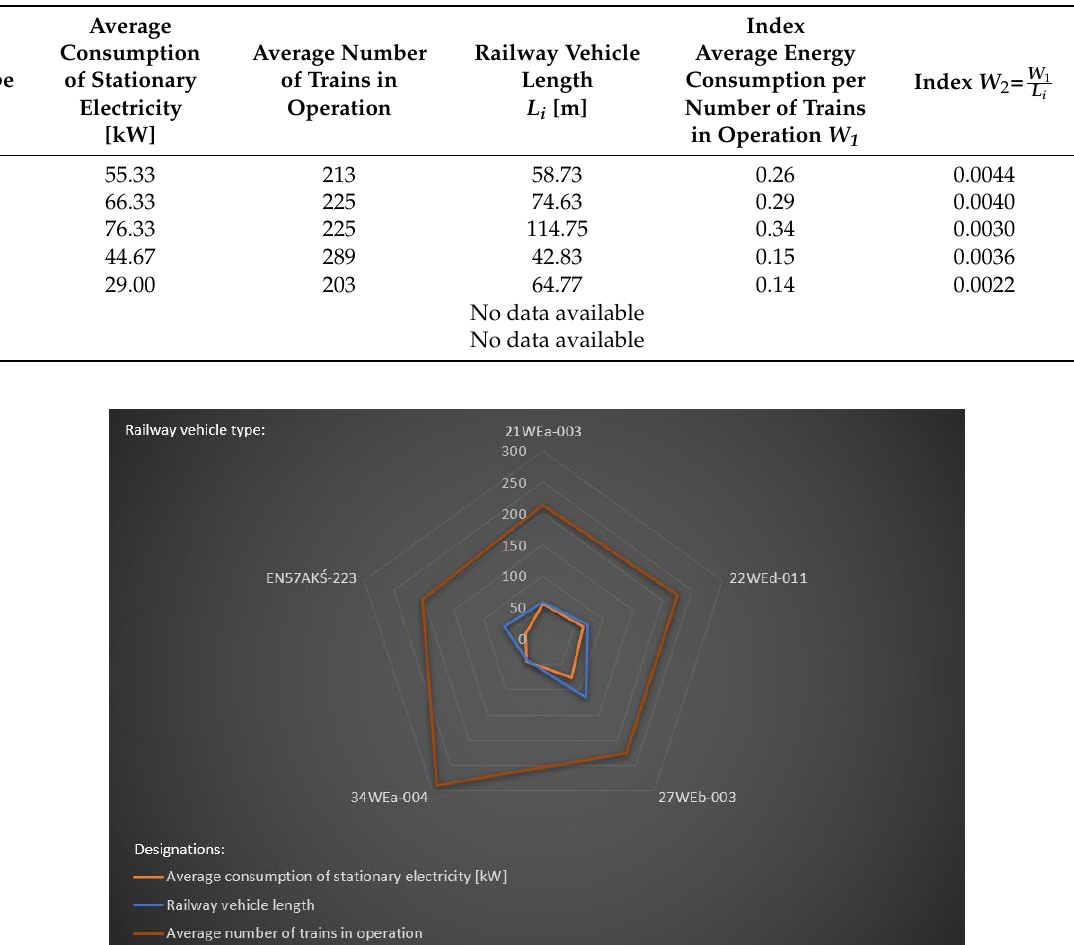
Table 5. Consumption of stationary electricity—For non-traction needs of railway vehicles—time